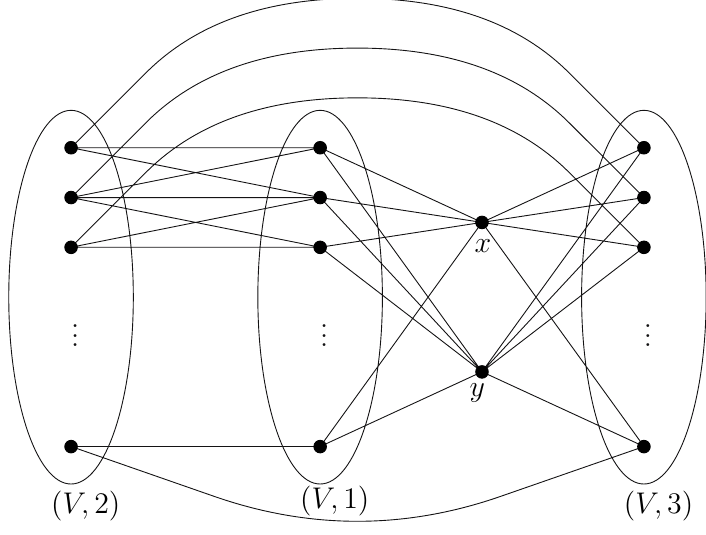
Fig. 6 Reduction from DS to DCDS for bipartite